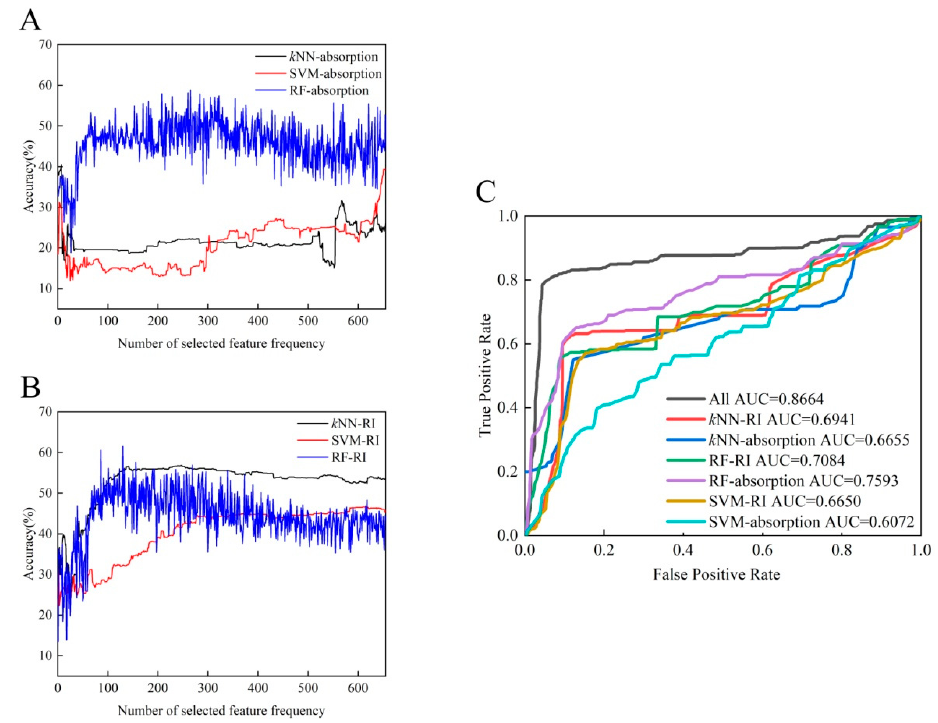
Figure 5. Diagnostic evaluation of the automated recognition method based on two characteristic parameters: absorption ( A ) and refractive index ( B ). ( C ) ROC curves and AUC scores for identifying clinical strains with three types of machine learning classifiers.